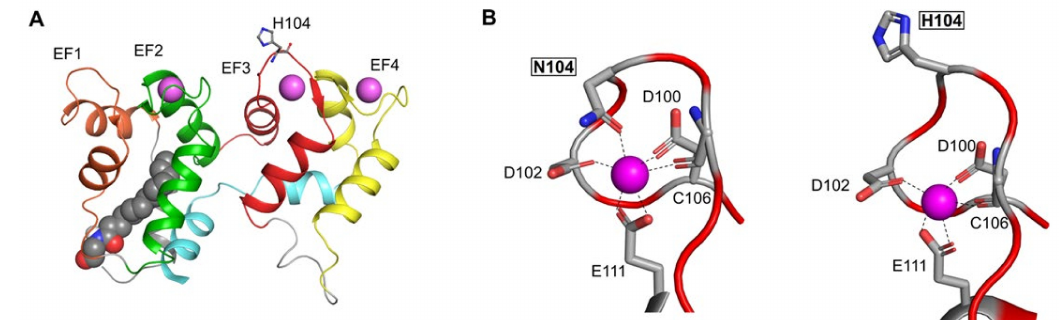
Figure 5. Structural model of N104H-GCAP1. ( A ) The 3D structural model of N104H-GCAP1 in the Ca 2+ -loaded form is depicted in the cartoon, with the N-terminal helix in grey, EF1 in orange, EF2 in green, EF3 in red, EF4 in yellow, the C-terminal helix in cyan. Ca 2+ ions and the myristoyl group are represented as pink and grey spheres, respectively, and mutated residue H104 is represented as sticks and colored by element. ( B ) Ca 2+ ion coordination is shown by key residues of EF3 in WT-GCAP1 (left) and N104H-GCAP1 (right). Structures depicted represent the last frames extracted from the first replica trajectories of both variants.